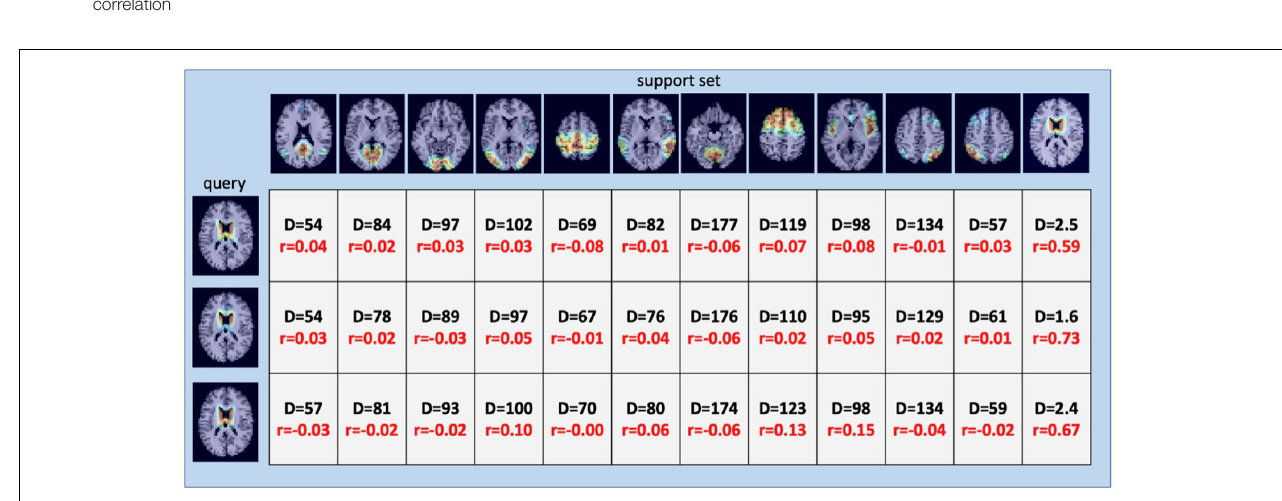
samples for the template matching methods were from the CNRM dataset. Our method was as good or better than the with more than 5 training